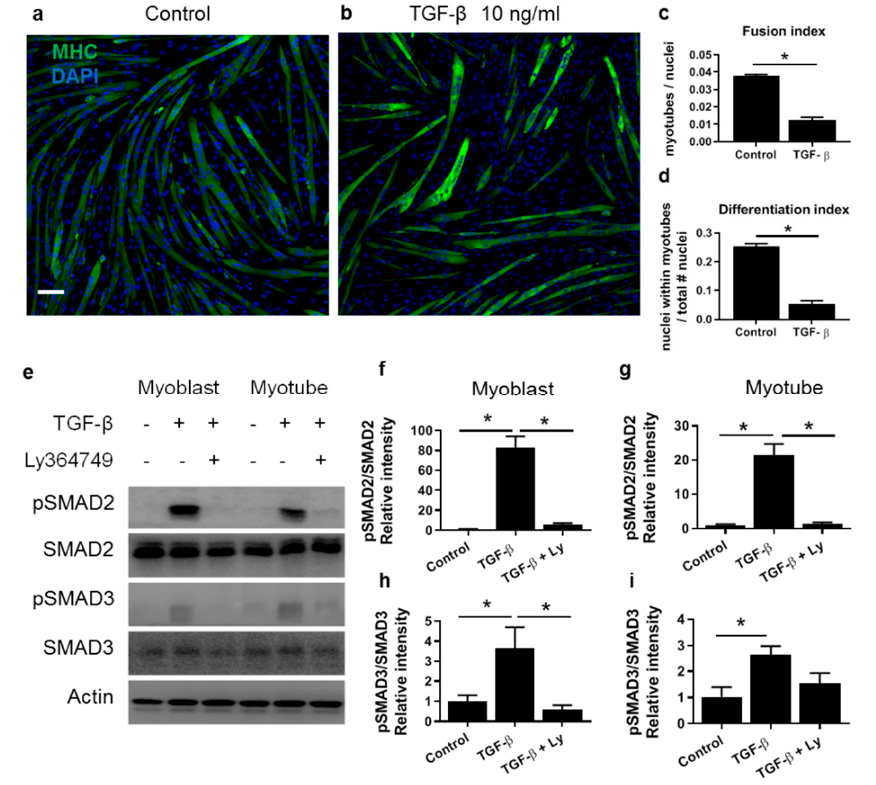
Figure 1. Transforming Growth Factor β (TGF- β ) inhibits C2C12 di ff erentiation. ( a , b ) C2C12 cells were induced to di ff erentiate in control medium ( a ) or medium supplemented with TGF- β ( b ). Myotubes were stained for myosin heavy chain (MHC) (green). Nuclei were stained using DAPI (blue). Scale indicates 100 µ m. ( c , d ) Fusion index, defined as number of myotubes ≥ 2 nuclei / total number of nuclei and di ff erentiation index defined as number of nuclei within MHC + myotubes / total number of nuclei were reduced after TGF- β . ( e , f , g , h , i ) In both myoblasts and myotubes, phosphorylation levels of SMAD2 ( f , g ) and SMAD3 ( h , i ) were increased upon 1 h of TGF- β treatment. Pan actin served as loading control. Phosphorylation levels are displayed as relative intensity of pSMAD/total SMAD. Data were normalized to values of control condition. Error bars indicate standard error of the mean; * indicates significant difference at p < 0.05; n = 4 experiments per condition.